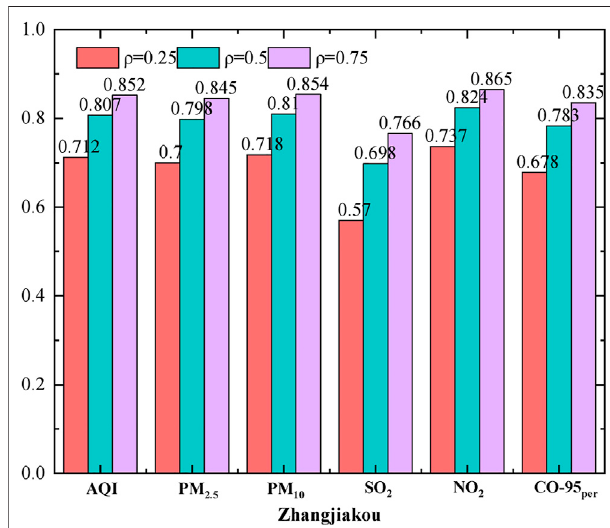
FIGURE 2 | Grey average correlation coef fi cient of air index under different resolution coef fi cients in Zhangjiakou.